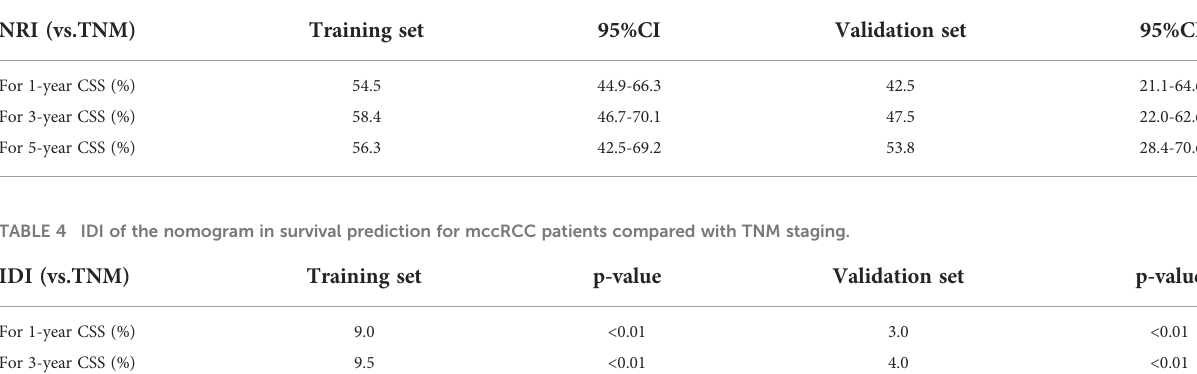
TABLE 3 NRI of the nomogram in survival prediction for mccRCC patients compared with TNM staging.